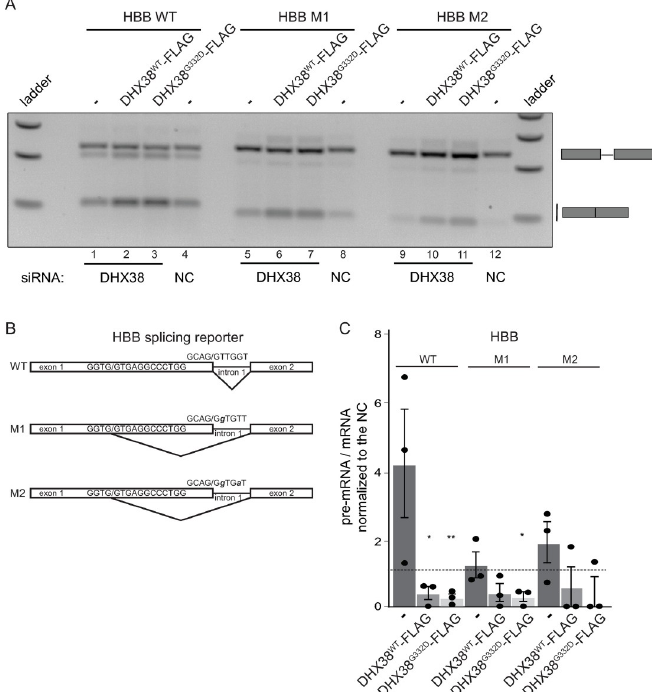
Fig 4. DHX38 promotes splicing of the HBB-derived reporter. (A) A representative gel of HBB-derived reporter splicing after DHX38 knockdown and expression of siRNA-resistant DHX38 WT -FLAG and DHX38 G332D -FLAG. (B) A scheme of HBB-derived reporter and M1 and M2 mutants that block usage of normal splice site and promote usage of upstream 5’ cryptic splice site. (C) Quantification of three independent experiments with the mean and SEM. Statistical significance was assessed by two tail unpaired t-test ( � indicates p � 0.05, �� p � 0.01).